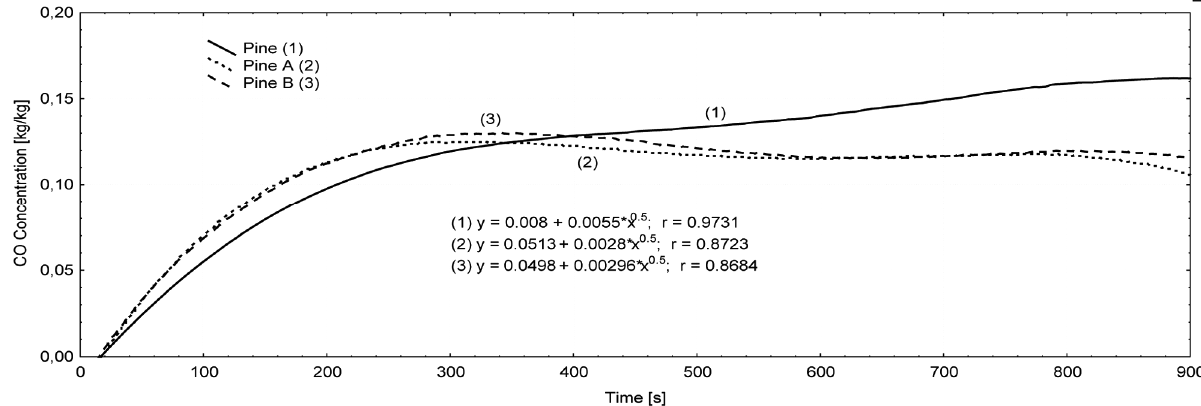
Fig. 7. Alternation of average CO concentration obtained during smouldering of tested specimens subjected to time: (1) – non-treated pine timber specimens; (2) – pine timber specimens treated with A; (3) – pine timber specimens treated with B